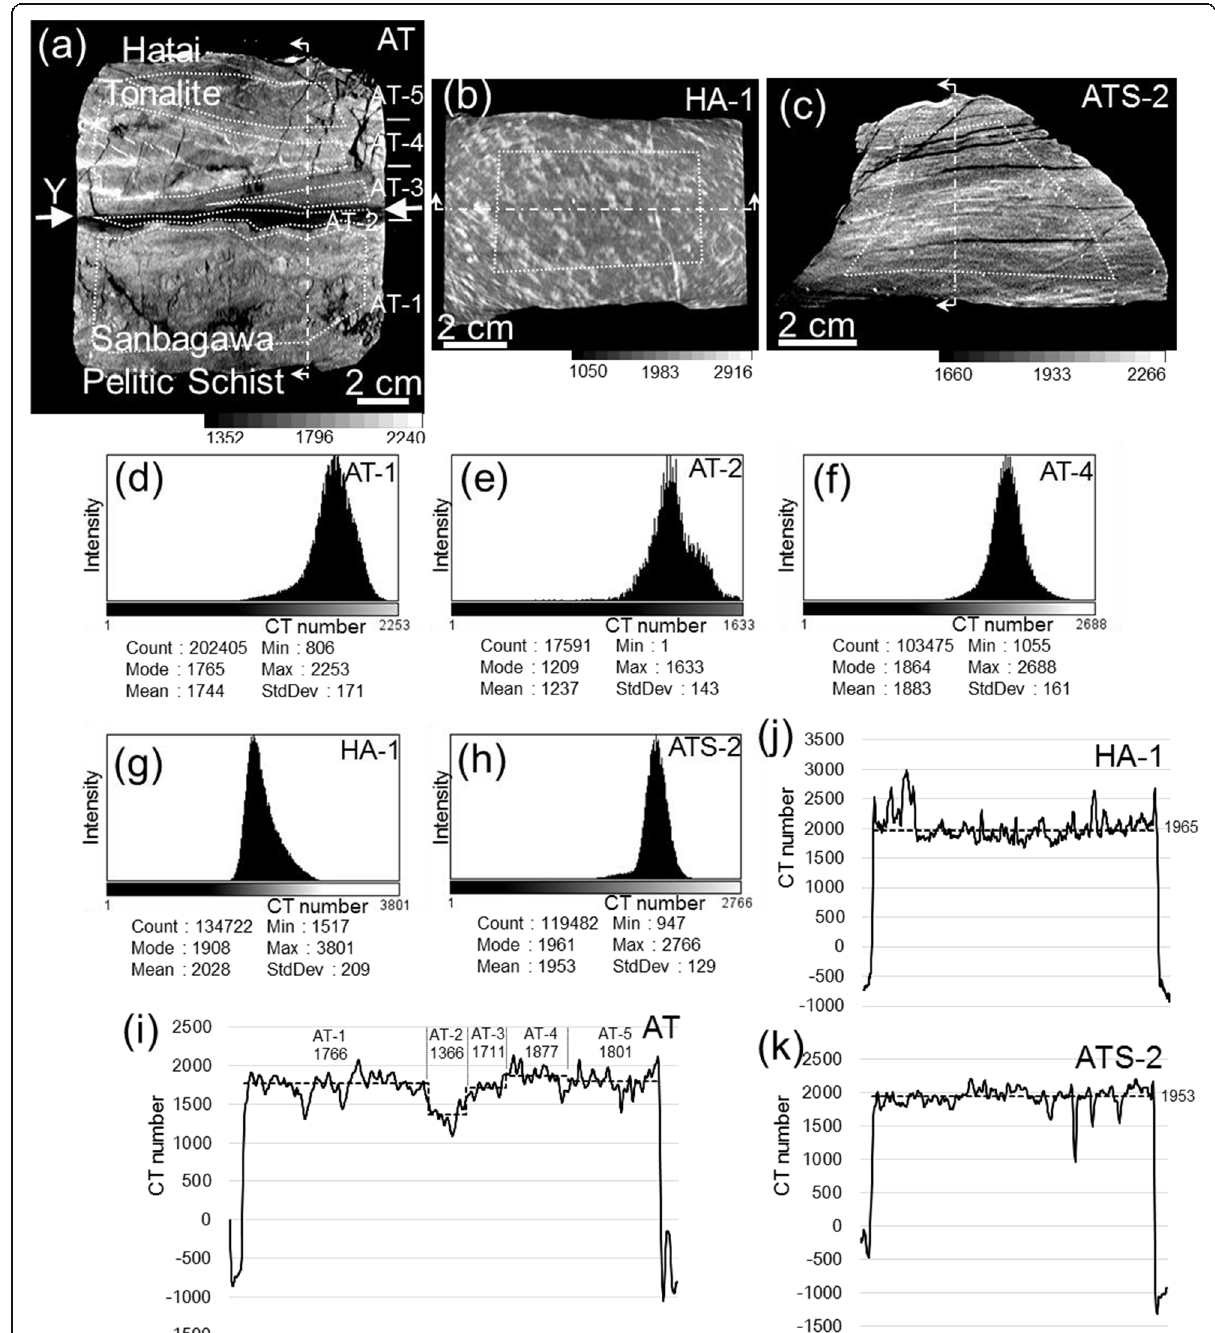
Fig. 7 X-ray CT image analysis results for the Awano – Tabiki outcrop samples. CT images of the a AT, b HA-1, and c ATS-2 samples. CT number histograms for the d AT-1, e AT-2, f AT-4, g HA-1, and h ATS-2 samples. The N CTM value for each zone was calculated near the center (within the white dotted lines in ( a ) – ( c )), with the peripheral areas excluded. CT number profiles for i AT, j HA-1, and k ATS-2, with the values calculated along the dash-dotted lines in ( a ) – ( c ),